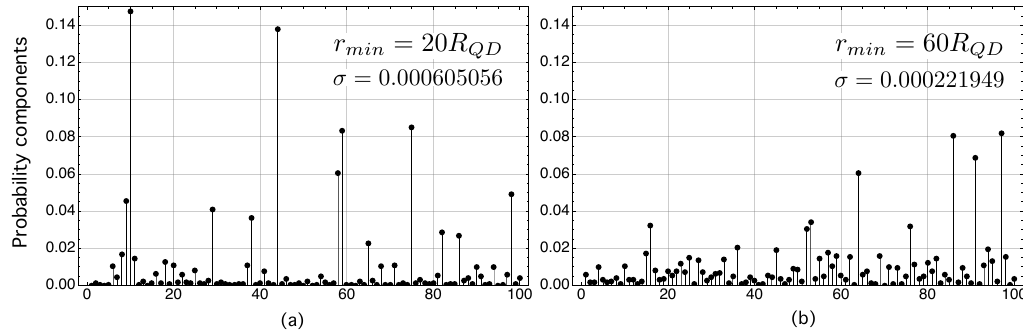
2 , on each of the kets ψ n | (cid:104) | (cid:105) |